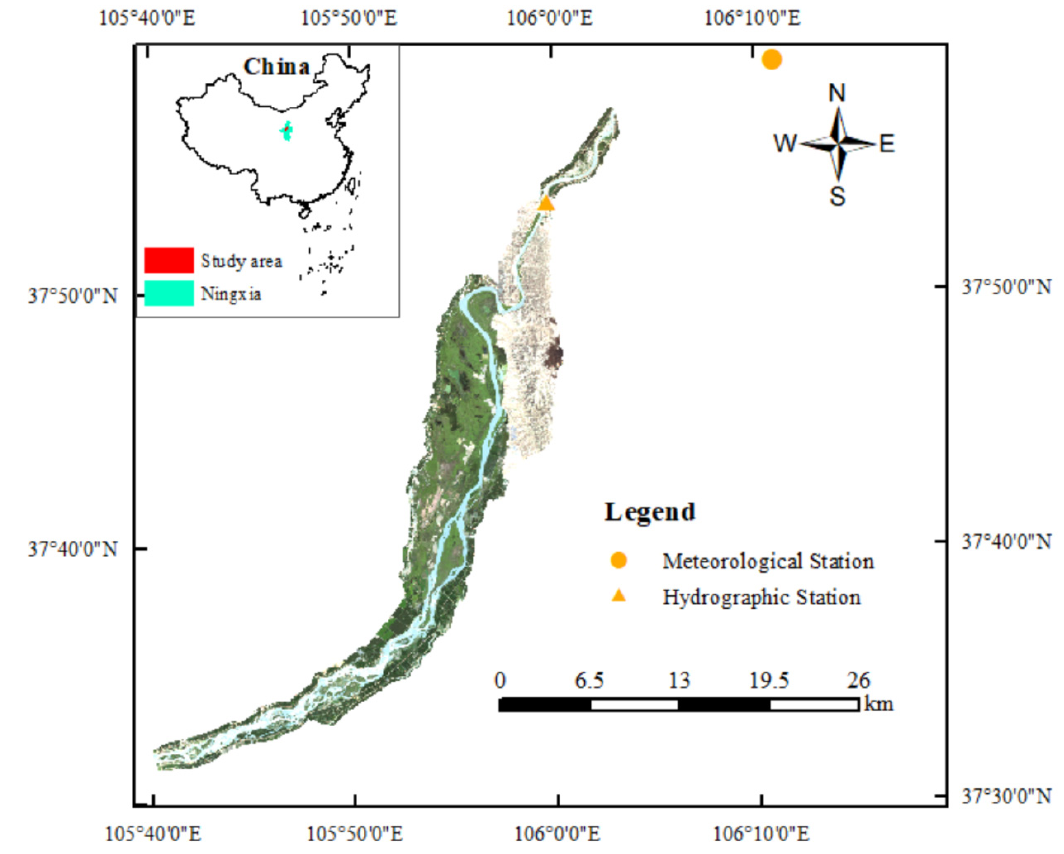
Figure 1. Location map of the study area.